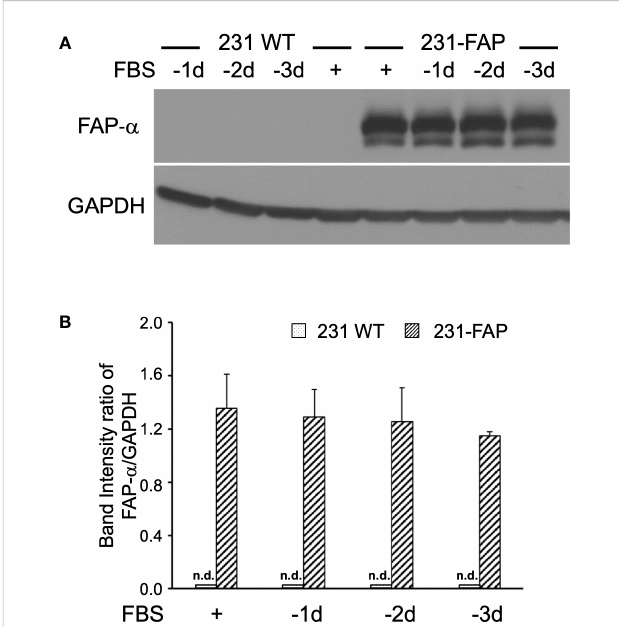
FIGURE 1 (A) Representative immunoblots of FAP- a with GAPDH used as loading control in 231 WT and 231-FAP cells cultured with (+) or without ( – ) FBS. -1d: 1 day without FBS. (B) Quantitative analysis of the immunoblots represented as band intensity ratio of FAP- a to GAPDH demonstrating signi fi cant increase of FAP- a in 231-FAP cells compared to 231 WT cells. Values represent Mean ± SEM (n = 2-3). n.d.,